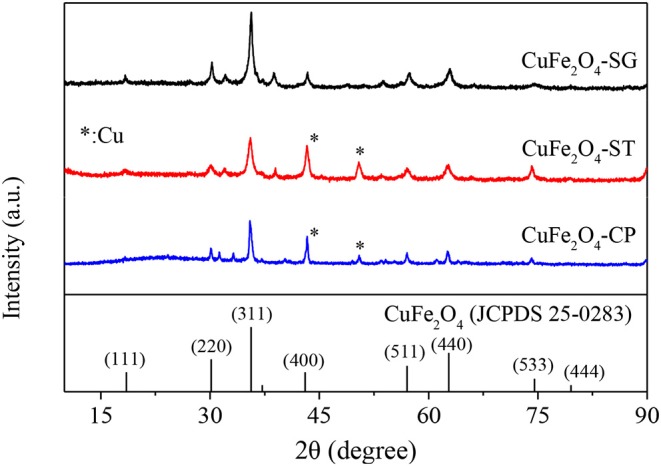
XRD patterns of CuFe2O4 synthesized by different methods.